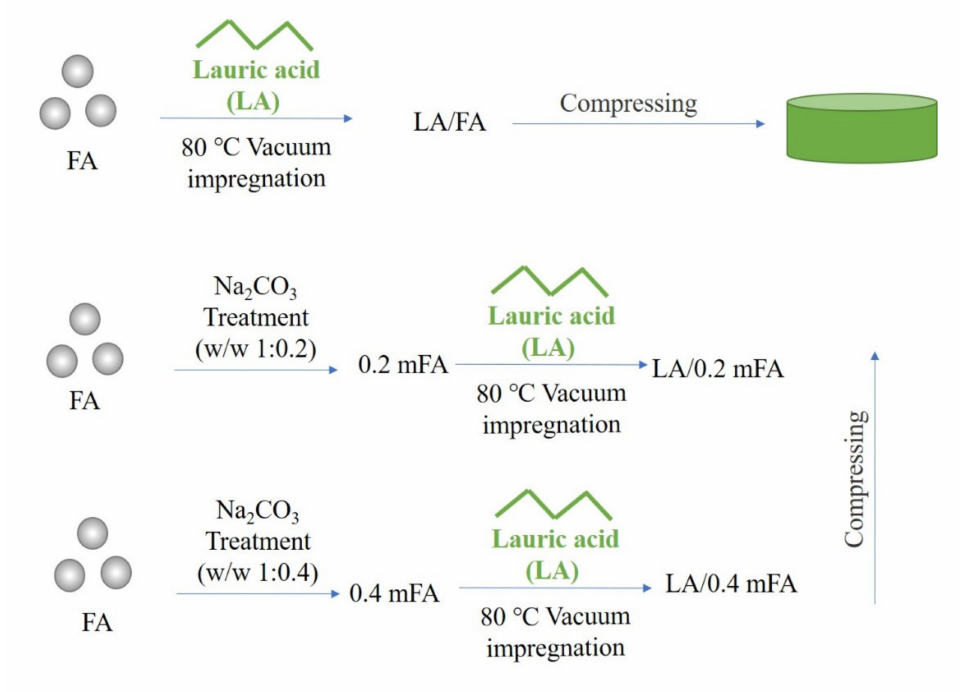
Figure 1. Block diagram of synthesis